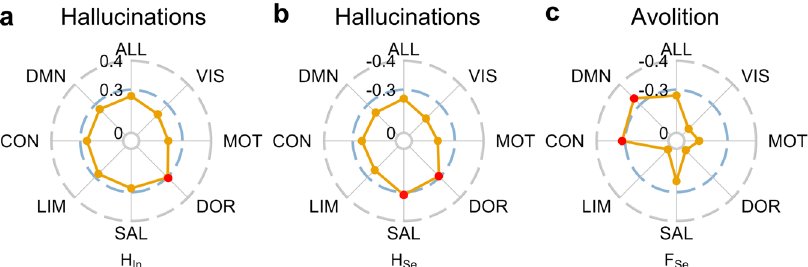
Fig. 2 Associations between resting-state brain networks and schizophrenia symptoms. a Correlations of hallucinations score to integration strength H In and b segregation strength H Se for the whole-brain (ALL) and seven functional systems. The red dots indicate signi fi cant correlations. c Correlations between avolition score and segregation variability F Se for the whole-brain (ALL) and functional systems (see Supplementary Data. 1 for more results of correlations between brain network measures and diverse clinical symptoms, see Supplementary Fig. 6 for similar results for the brain parcellation of 500 regions).